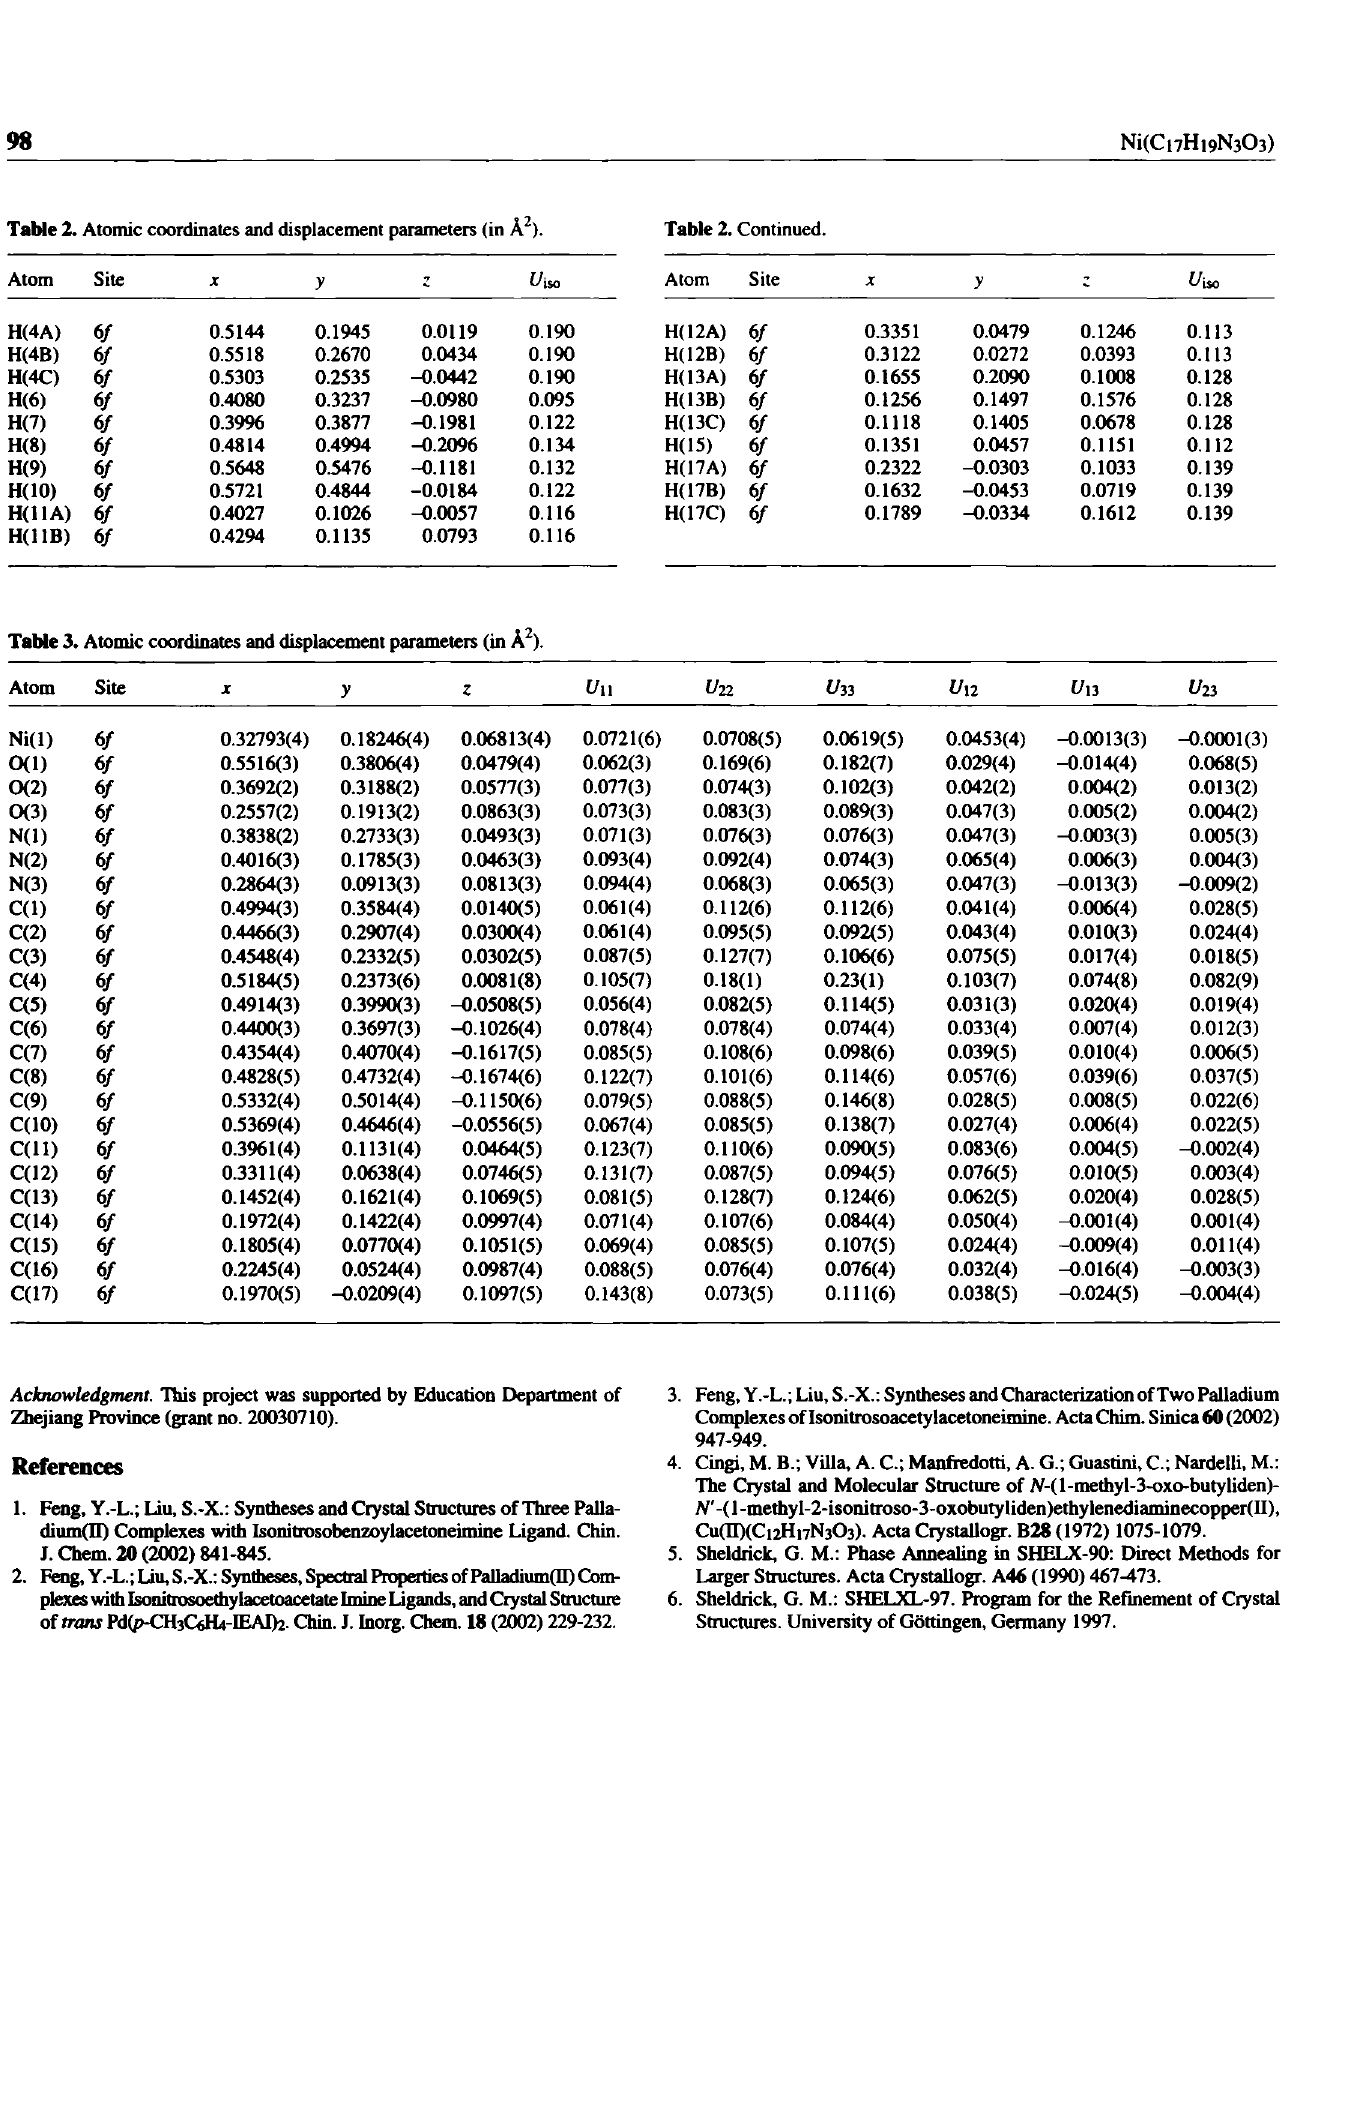
Table 3. Atomic coordinates and displacement parameters (in A 2